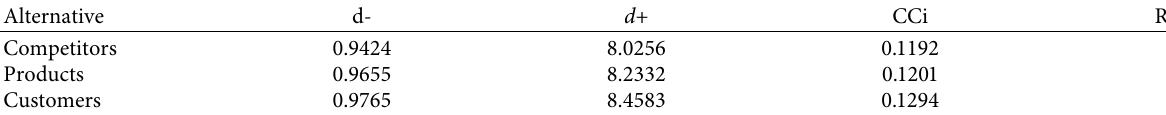
Table 13: Weighted normalized fuzzy decision matrix.